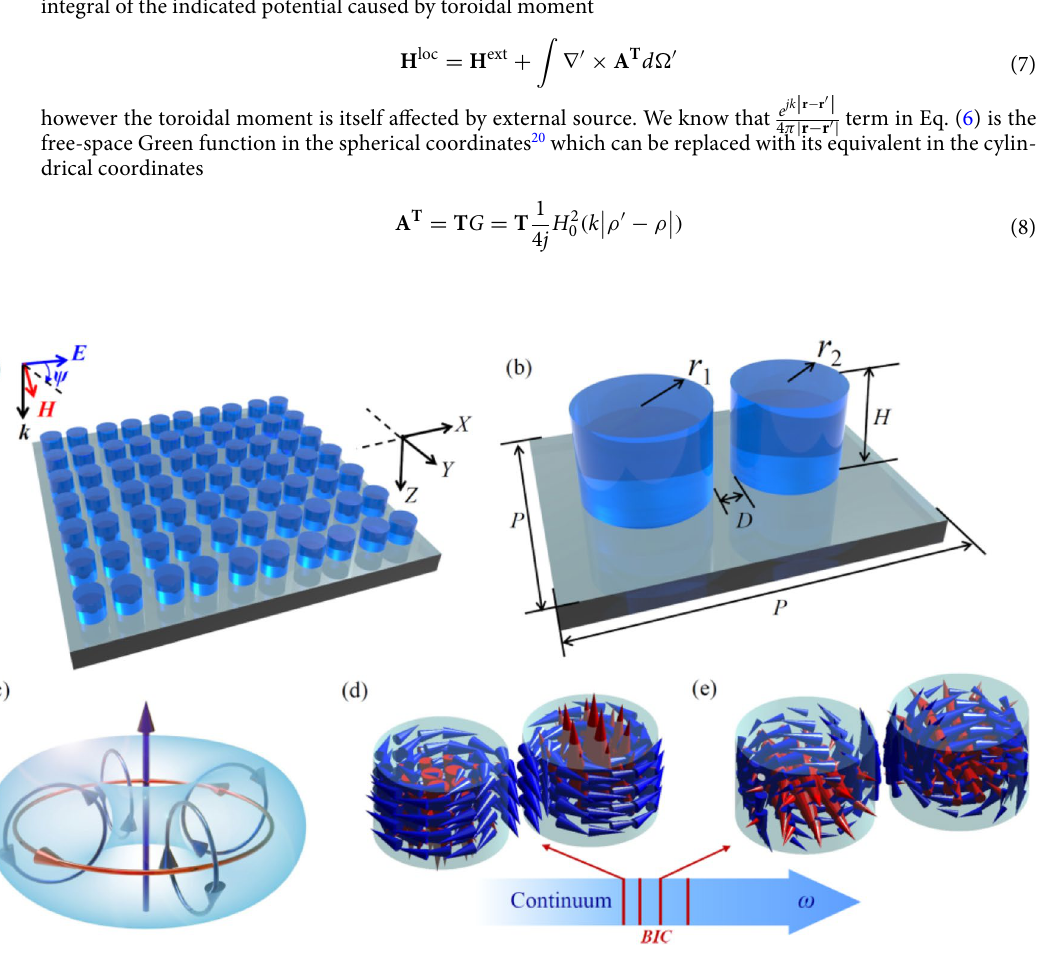
Figure 3. ( a ) A diagram of an all-dielectric metasurface. ( b ) The metasurface’s unit cell. r 1 , 2 denotes the radius of the constituent nanodisks, H is the height of the disks, D is the distance between two nanodisks in the unit cell, and P is the lattice constant. ( c ) Diagram of a TD moment. ( d ) and ( e ) Two metasurface eigenmodes having TD moments along the Y and Z axes 18